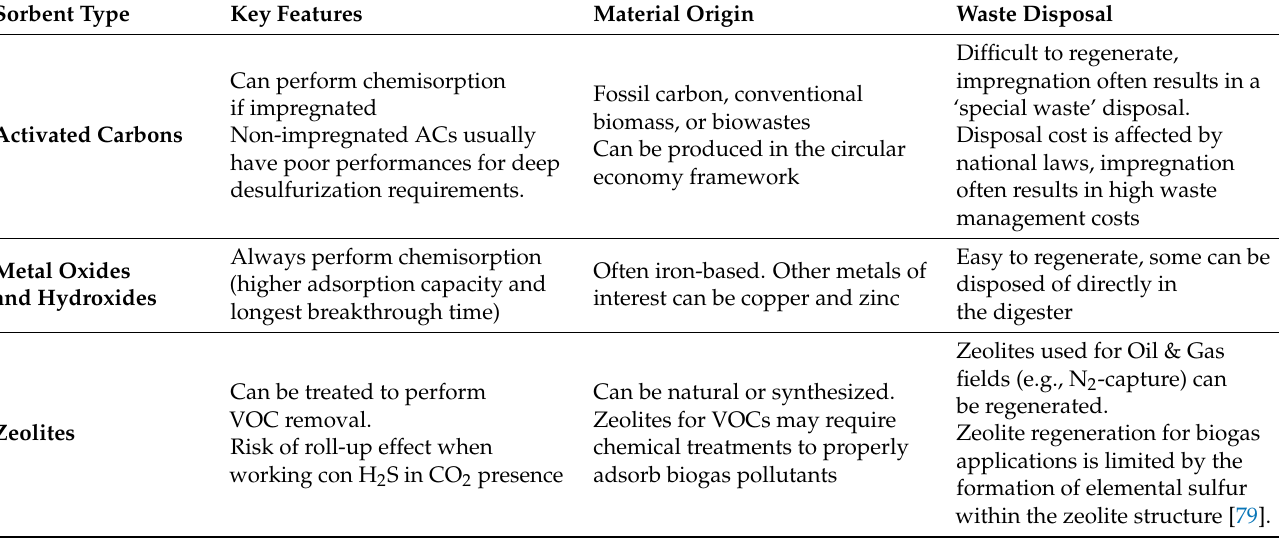
Table 6. Main positive aspects and criticalities in ACs, MeOx, and Zeolites use for biogas